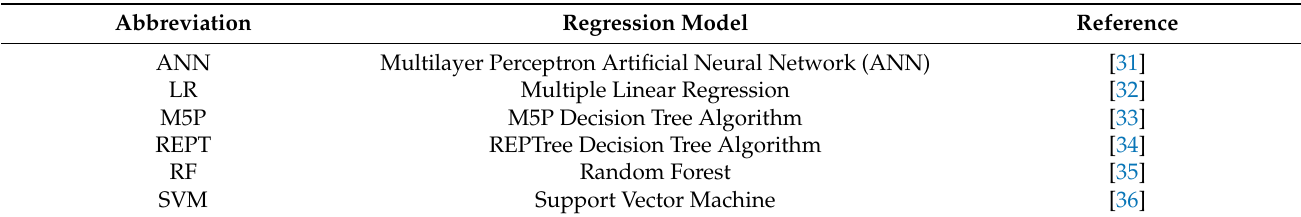
Table 2. List of machine learning models used in maize yield